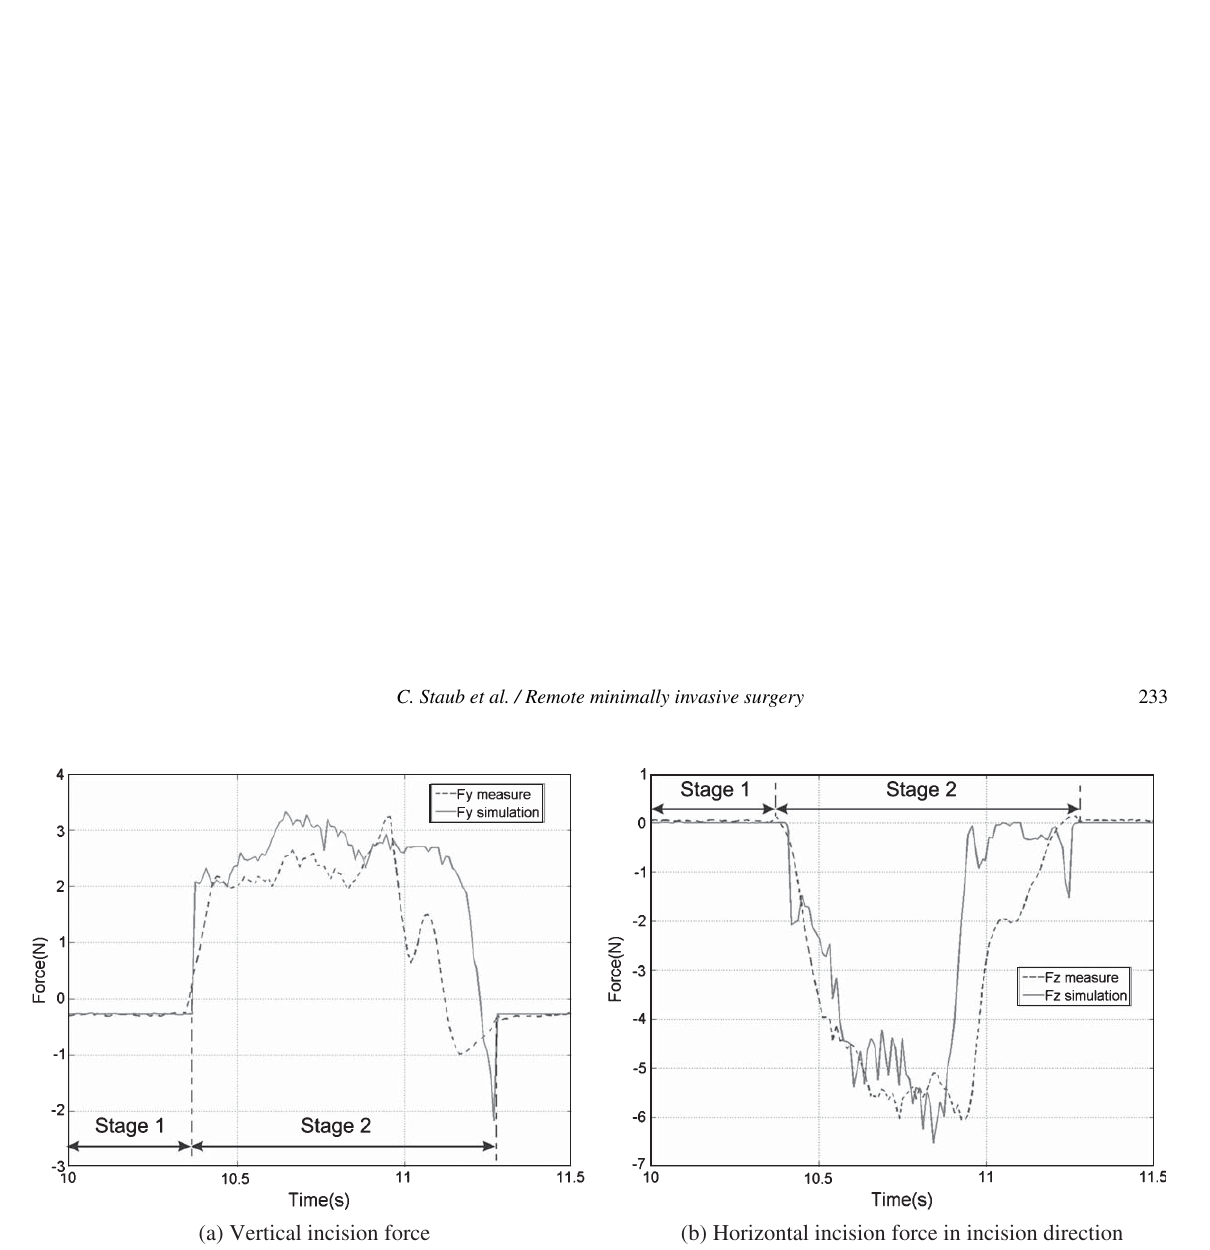
Fig. 9. Precision of force model versus the actual